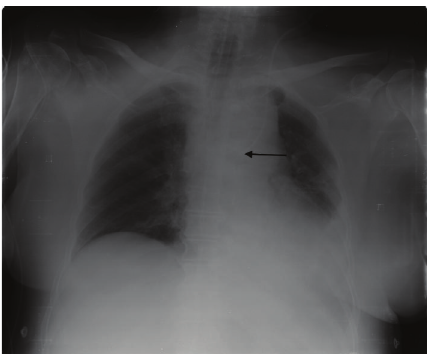
Figure 1: Chest radiograph showing tip (arrow) projecting over the left side of the descending aorta, at the level of carina, creating an angle with the spine greater than 40 ∘ .